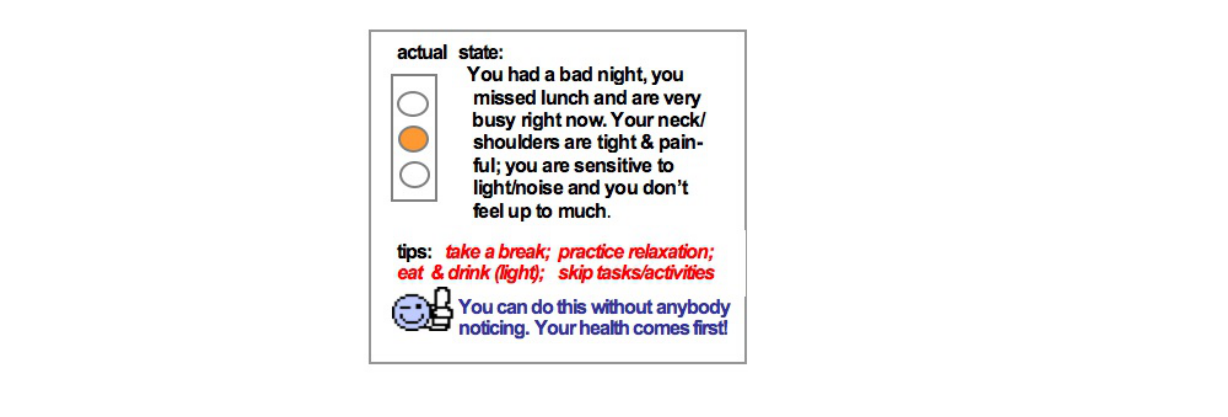
Figure 3. Example of the components of ODA feedback taken from the present ODA application in